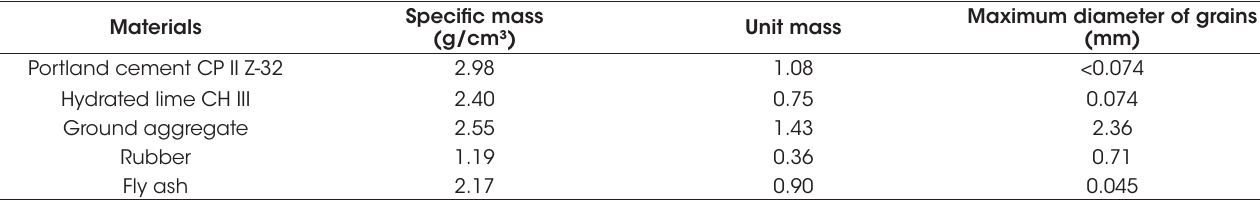
Fresh-state mortar properties